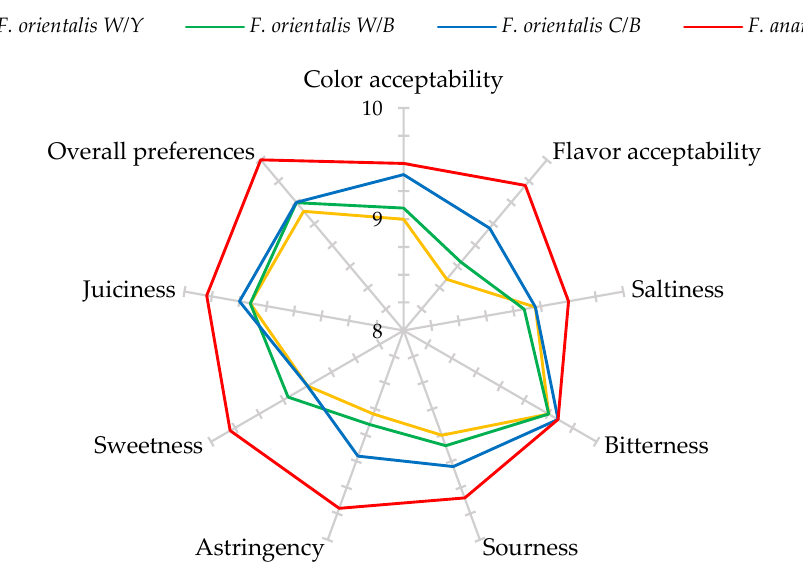
Figure 3. Sensory profiles of F. orientalis fruits, according to estimates by 60 participants. The preference scale ranged from 0 (greatest imaginary dislike) to 10 (greatest imaginary like). Fruits of F. ananassa were used as a reference sample. Samples notation: B—Buryatia origin; C—cultivated; W—wild; Y—Yakutia